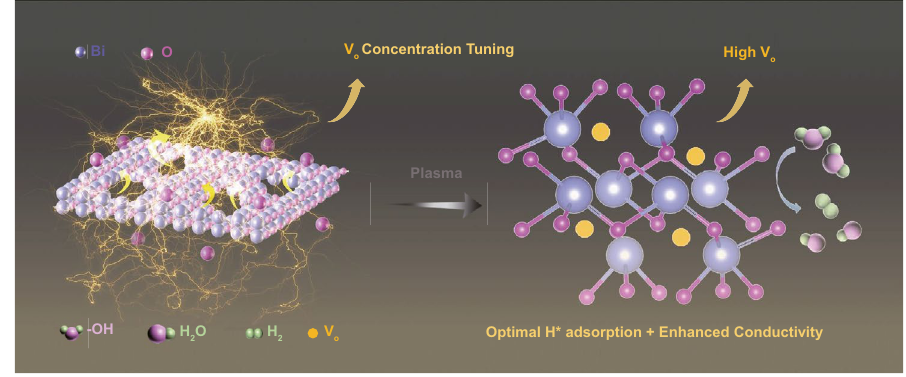
Fig. 1 Schematic illustration of plasma irradiation on the formation of oxygen vacancies in 2D Bi 2 O 3 nanosheets for electrocatalytic